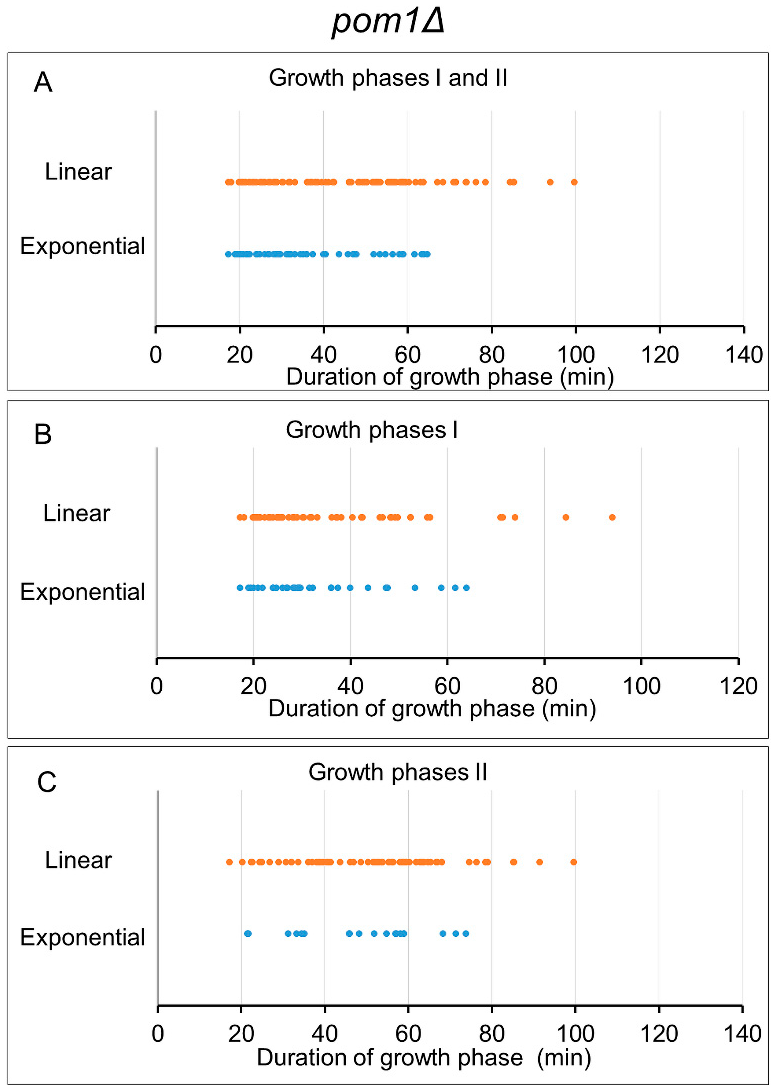
Figure 6. Distribution of the growing segments, examined in the ‘bilinearly’ growing pom1 ∆ mutant fission yeast cells. The growth phases are separated by the more adequate fitted model (linear or exponential). The symbols represent the growing segments, whose durations are given in minutes. ( A ) All the growth phases (I and II) are shown. ( B ) Only growth phase I is shown. ( C ). Only growth phase II is shown.